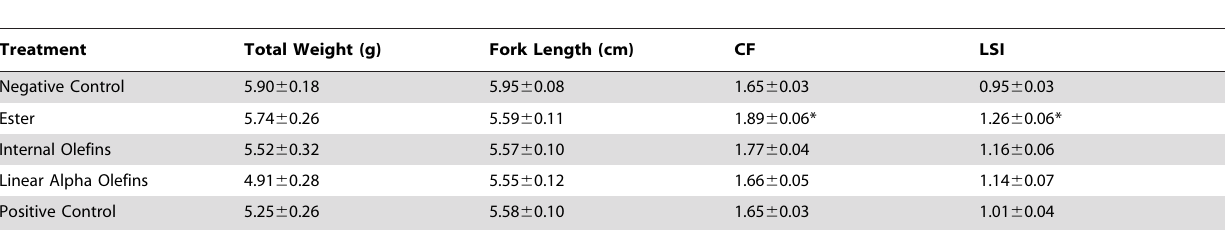
Table 3. Physiological parameters for juvenile pink snapper exposed to ester, internal olefins, and linear alpha olefins-based drilling muds for 28